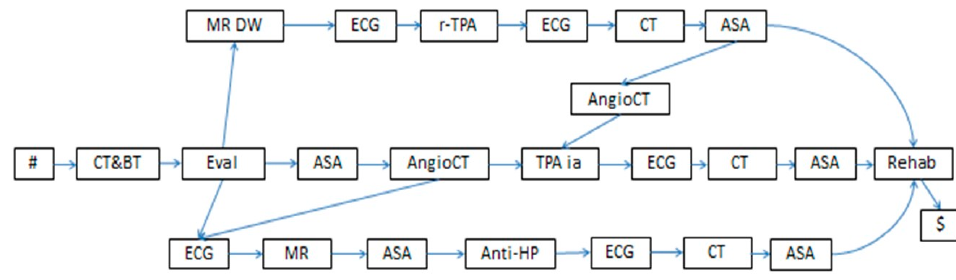
Figure 3. Process model after the merge operations.